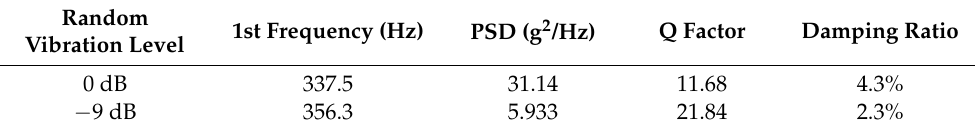
Table 9. First frequency and Q factor change according to the rise of vibration